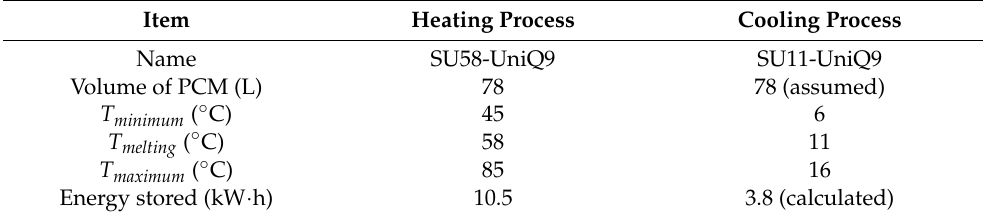
Table 1. Characteristics of Sunamp TBs